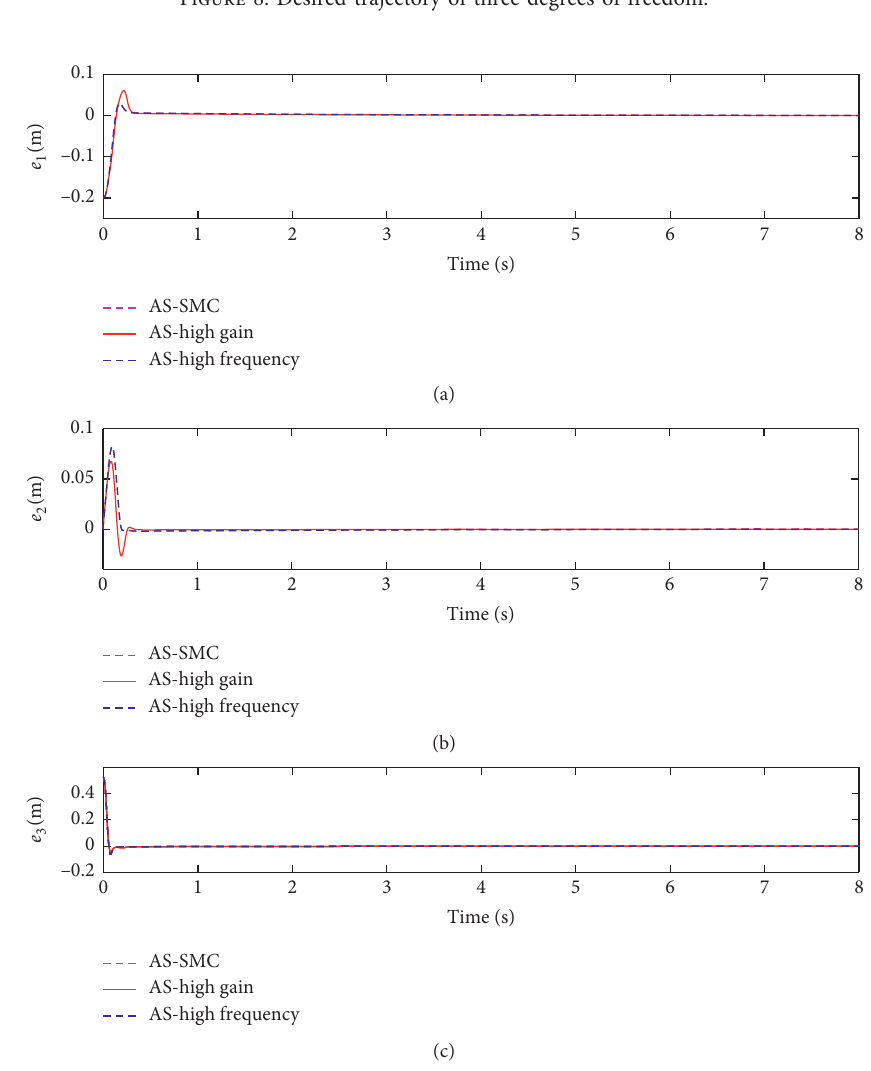
Figure 9: The trajectory tracking error.